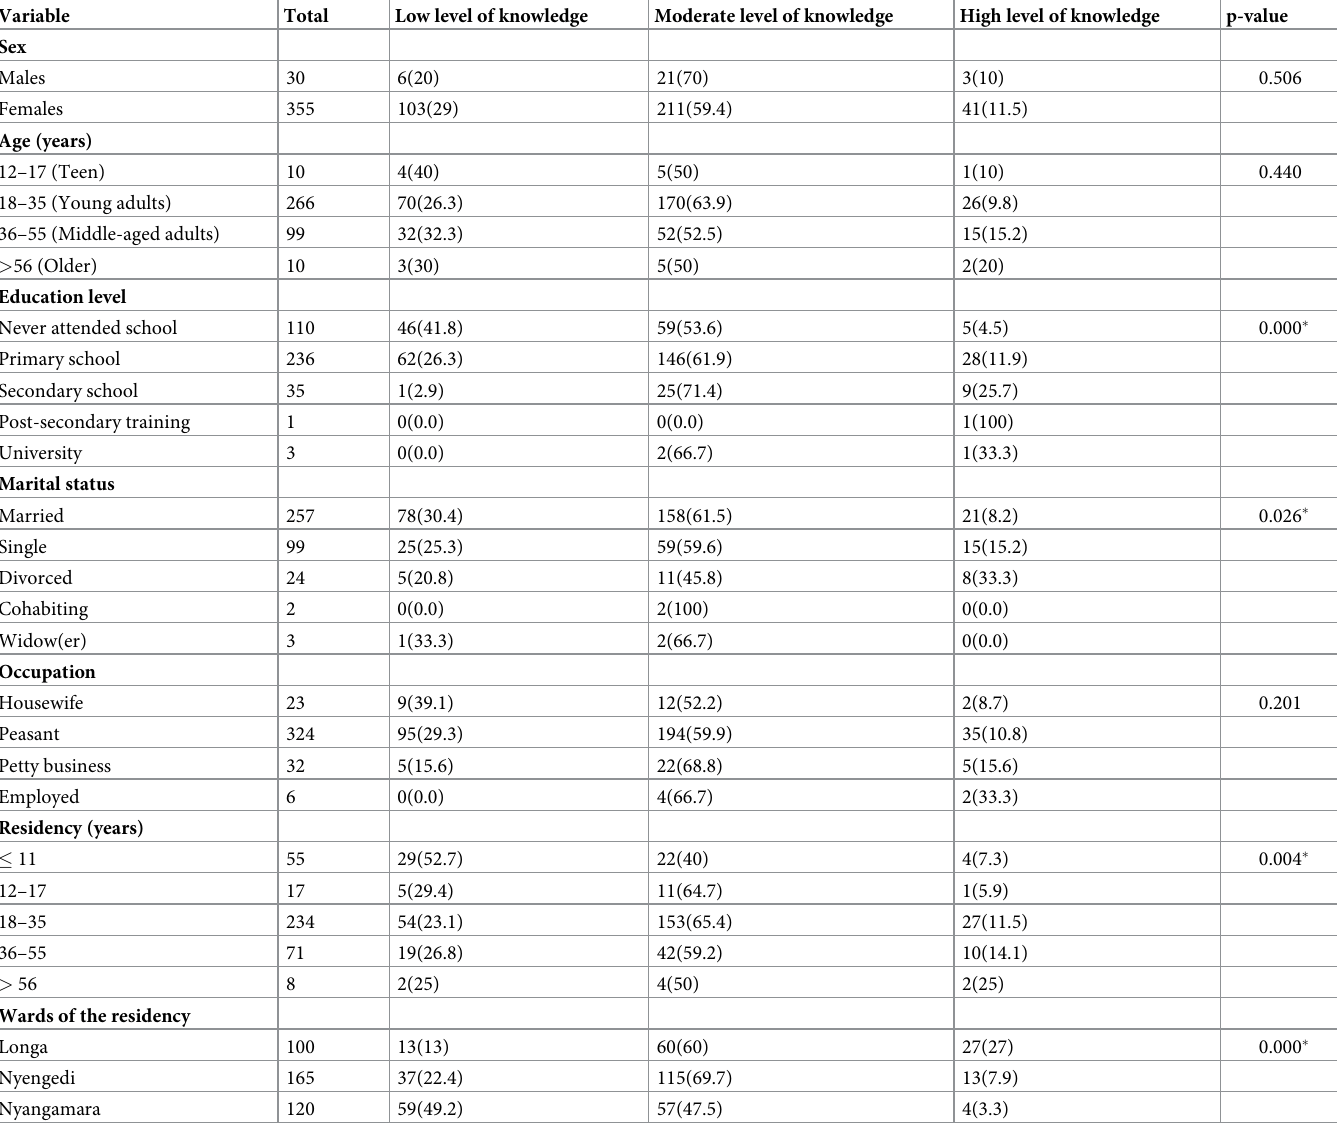
Table 4. Influence of socio-demographic characteristics of the parents/guardians on the level of knowledge on the urogenital schistosomiasis among the study par- ticipants (n = 385).